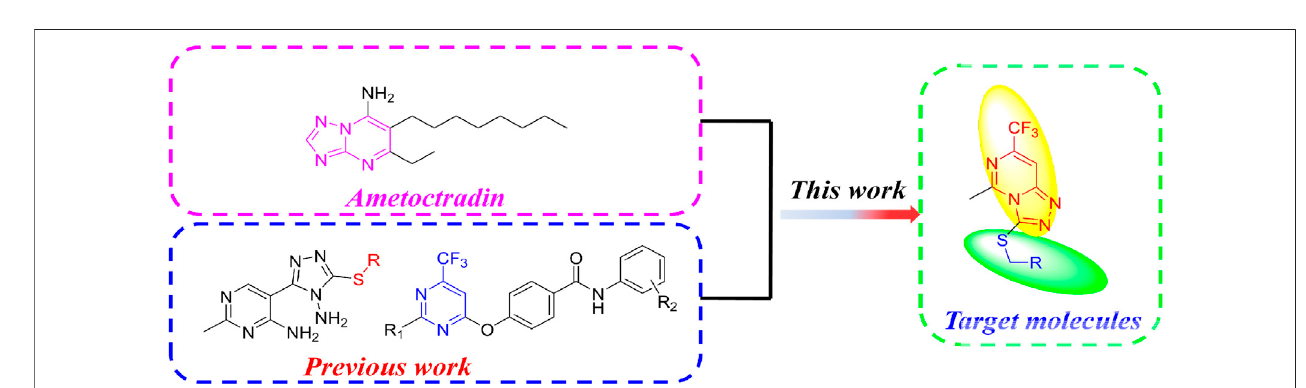
FIGURE 2 | Design of the target